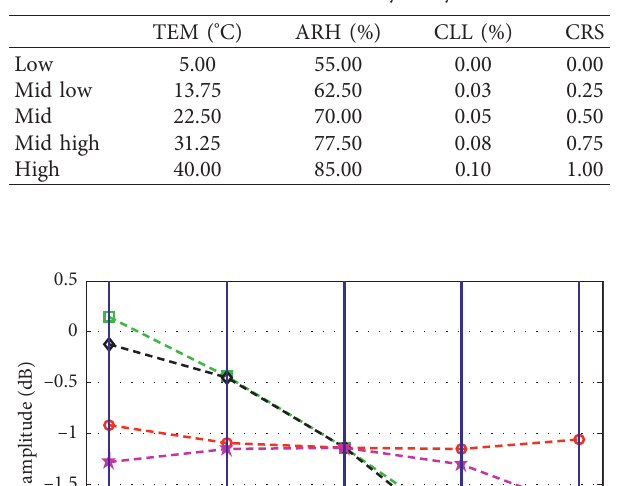
Table 7: Data for sensitivity analysis.